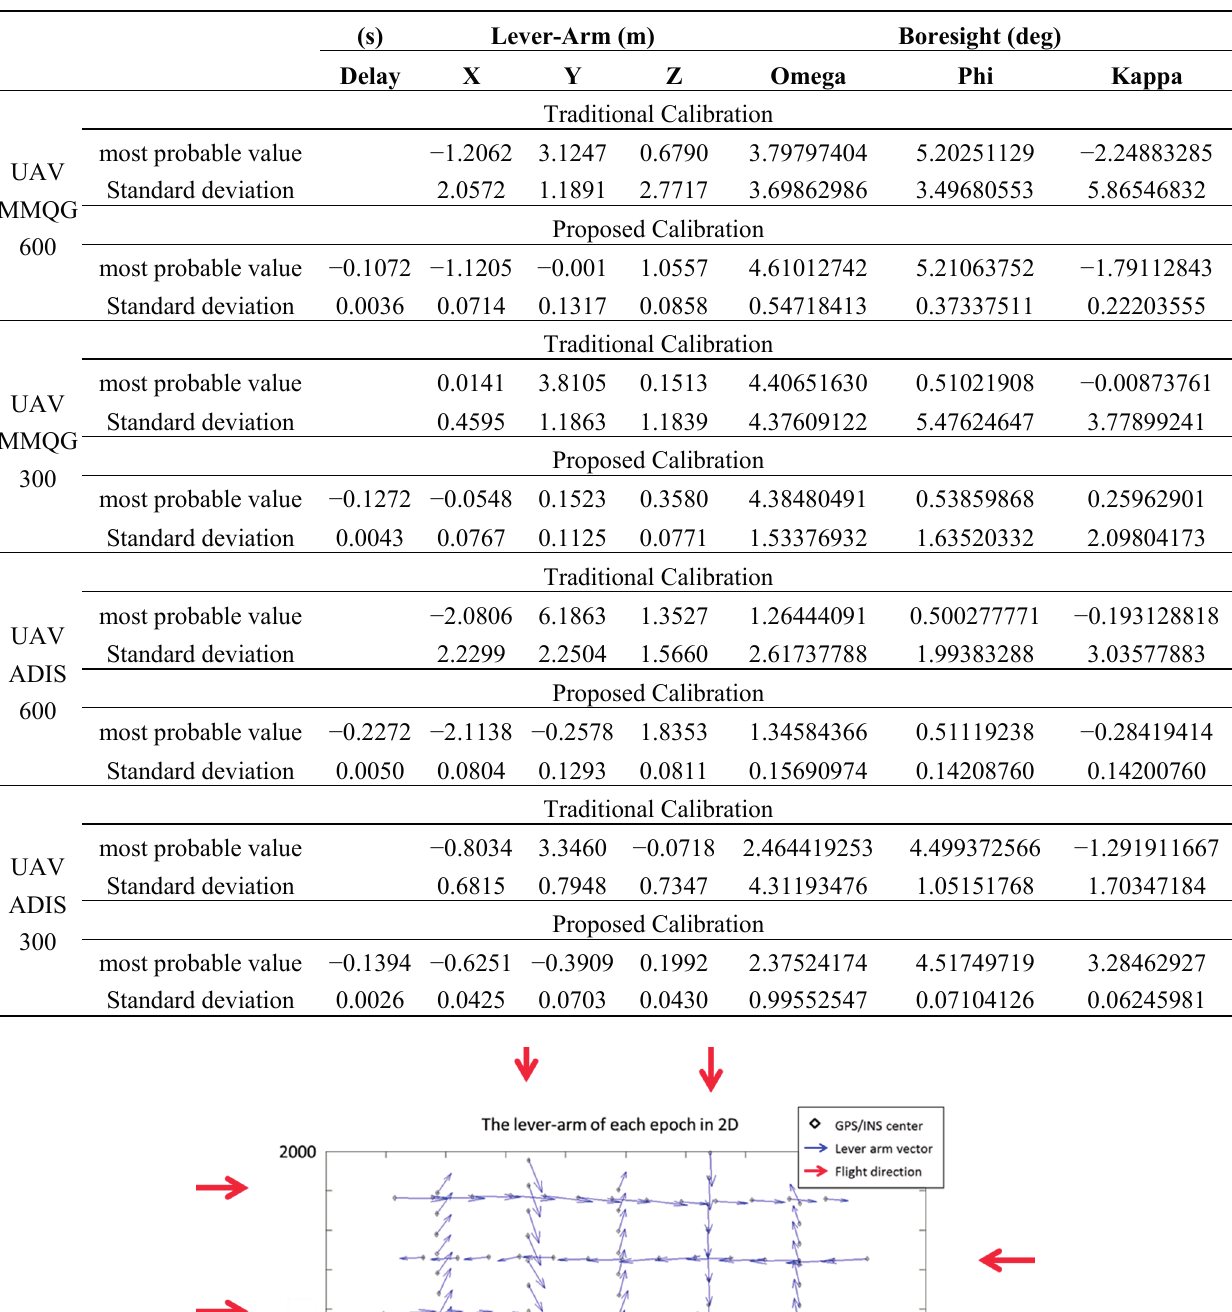
Table 1. The results of two calibration methods.